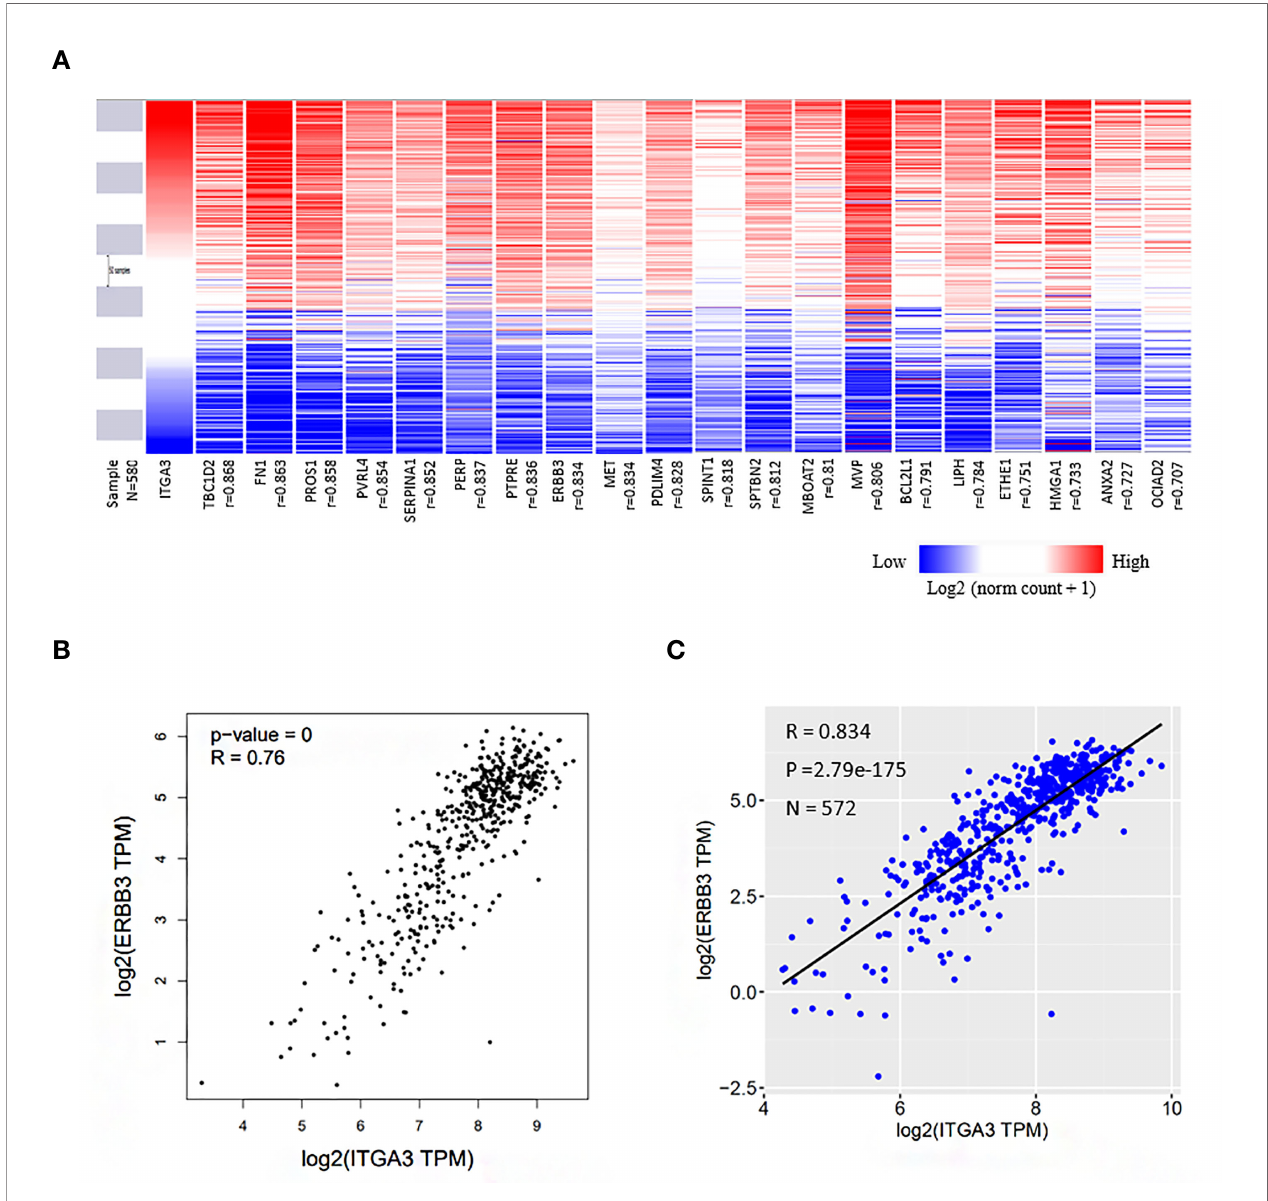
FIGURE 6 | Co-expression genes of ITGA3 in thyroid cancer. (A) Heat map of the co-expression pro fi le of ITGA3 in thyroid cancer plotted by the UCSC Xena web- based tools. The co-altered gene list was obtained from GEPIA database in which the dataset of thyroid cancer was also from TCGA. (B) Correlation between ITGA3 and ERBB3 in GEPIA database. (C) Correlation between ITGA3 and ERBB3 expression in thyroid carcinoma using the UCSC Xena